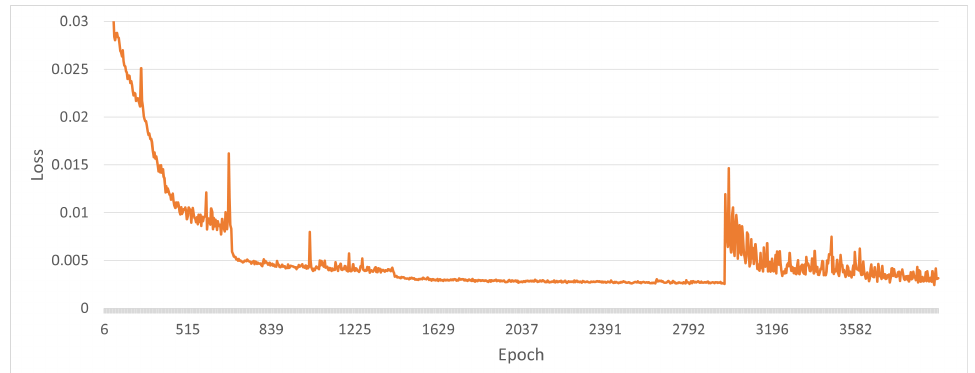
Figure 9. The example of a learning curve with fine-tuning (E7, S7). A vertical axis shows the loss value and a horizontal axis shows the number of